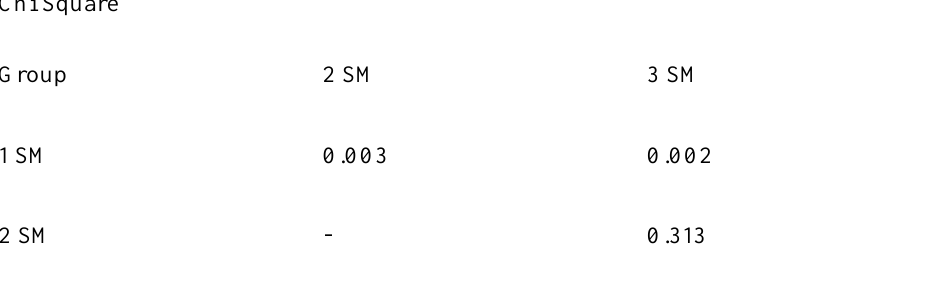
Chi Square of Critical Thinking Postings by SM Size Chi